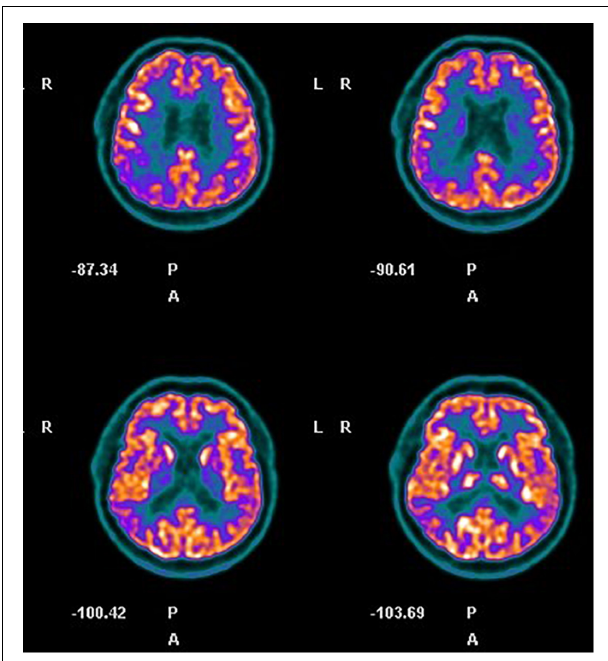
FIGURE 2 | Case 2, cerebral FDG-PET. Hypometabolism in right parietal and temporal areas and at the anterior cingulate cortex is